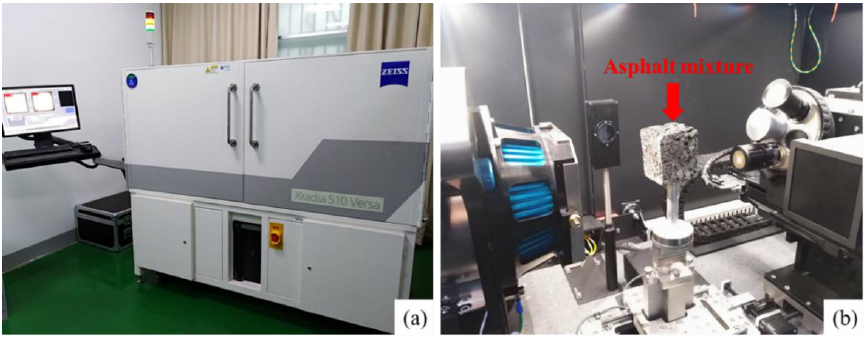
Figure 4. X-ray CT ( a ) and mixture been scanning ( b ).